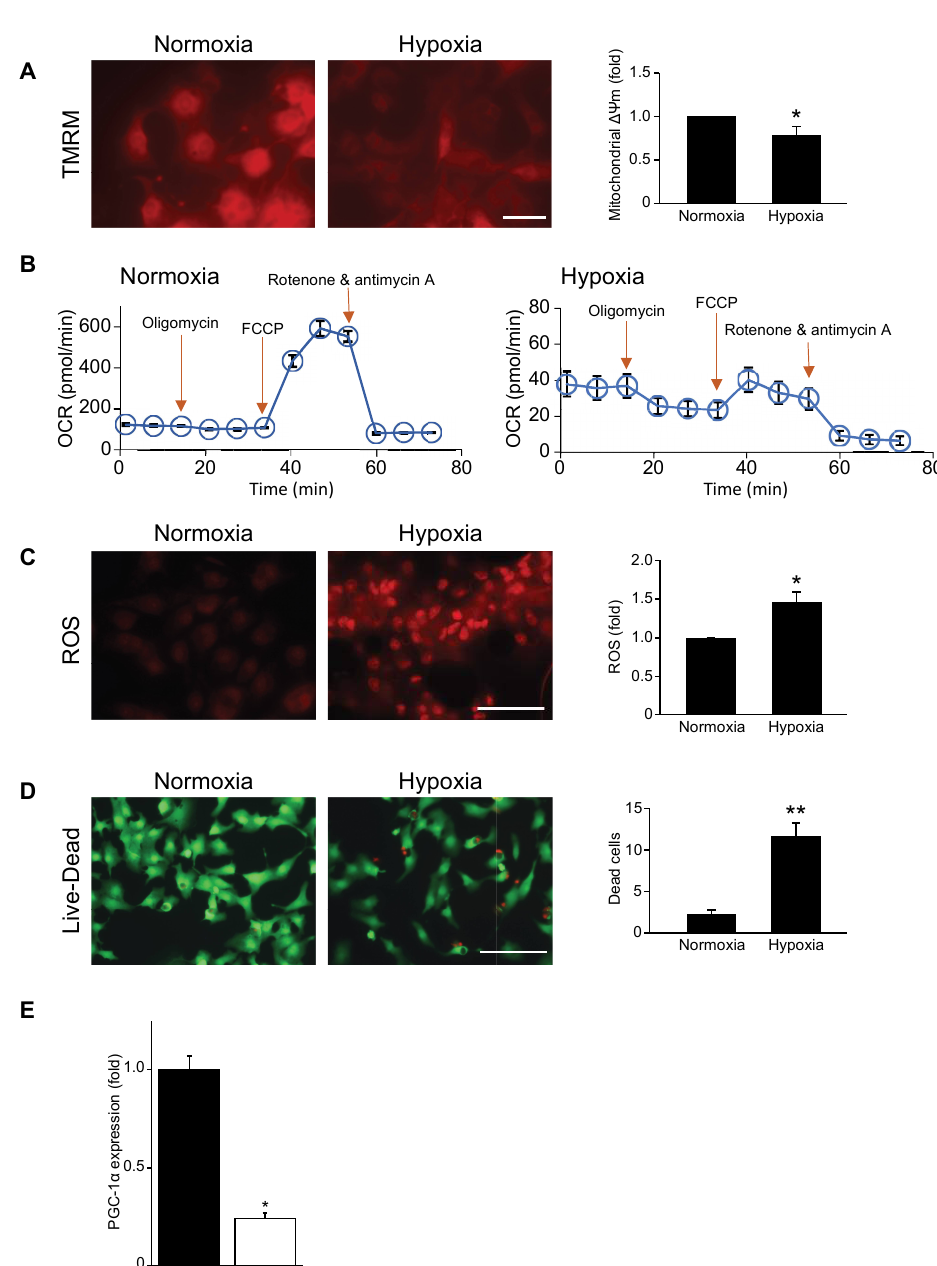
Figure 1. Mitochondrial function, respiration, and cell viability are impaired in hypoxic cardiac myocytes. ( A ) Mitochondrial membrane potential ( ∆Ψ m) during normoxia and hypoxia as assessed by tetra-methylrhodamine methylester perchlorate (TMRM) staining (red fluorescence); bar: 20 µ m. ( B ) Mitochondrial oxygen consumption rate (OCR) in neonatal rat cardiac myocytes subjected to normoxia (left panel) and hypoxia (right panel) from 6 to 8 wells per condition and from 3 to 4 independent myocyte isolations. ( C ) Mitochondrial reactive oxygen species (ROS) during normoxia and hypoxia as assessed by dihydroethidium staining (red fluorescence); bar: 100 µ m. ( D ) Cell viability during normoxia and hypoxia. Green cells indicate live cells and red cells indicate dead cells; bar: 100 µ m. ( E ) PGC-1 α mRNA expression under normoxic and hypoxic conditions; mRNA levels were normalized to Gapdh. Data are expressed as mean ± SEM. * p < 0.05 or ** p < 0.01 versus normoxia, n = 3–4 independent myocyte